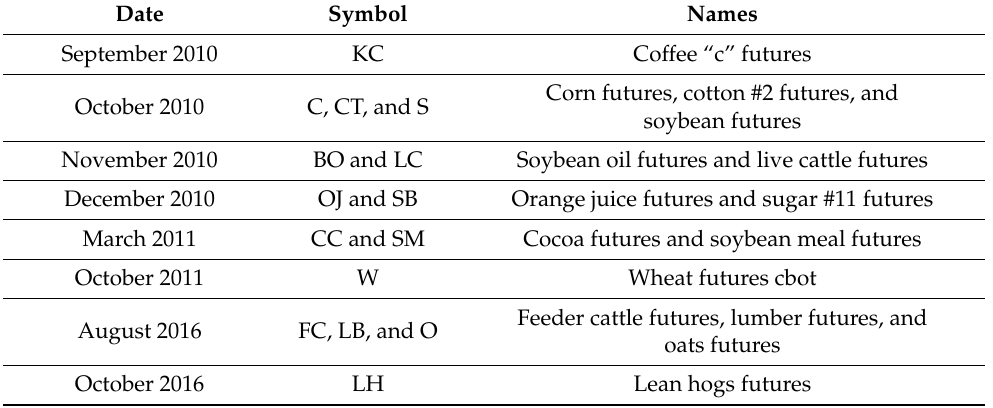
Table 1. Structural